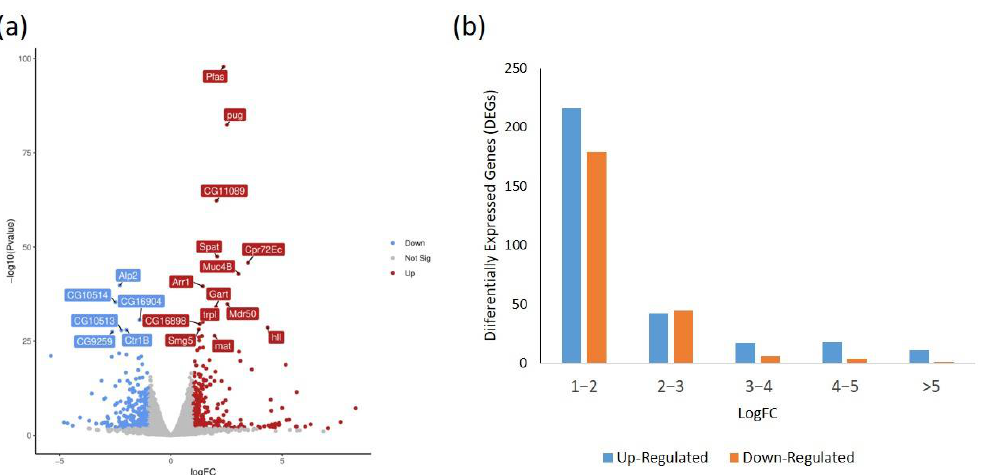
Figure 4. Gene expression changes in Drosophila on habanero-pepper versus control diet. ( a ) Vol- cano plot showing the Log2 fold change (FC) of differentially expressed genes. The Log2FC is plot- ted on the x-axis and the p -value on the y-axis. ( b ) Distribution of fold-change of gene expression in Drosophila on a habanero-pepper versus control diet. Down: downregulated; Up: upregulated.